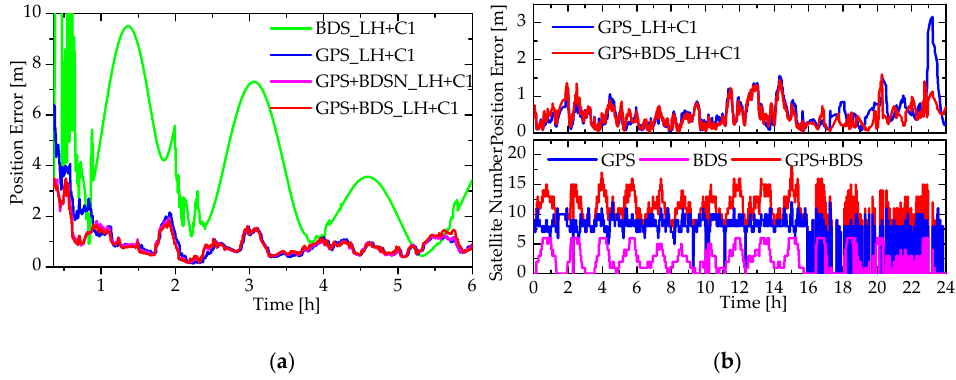
Figure 12. Impact of GPS/BDS fusion: ( a ) Position errors of the FY3C satellite at the convergent stage with the carrier-phase-based solutions for different GPS/BDS combinations on day 2015/69; ( b ) Position errors of the FY3C satellite with the carrier-phase-based solutions and the number of tracked GNSS satellites on day 2015/74.